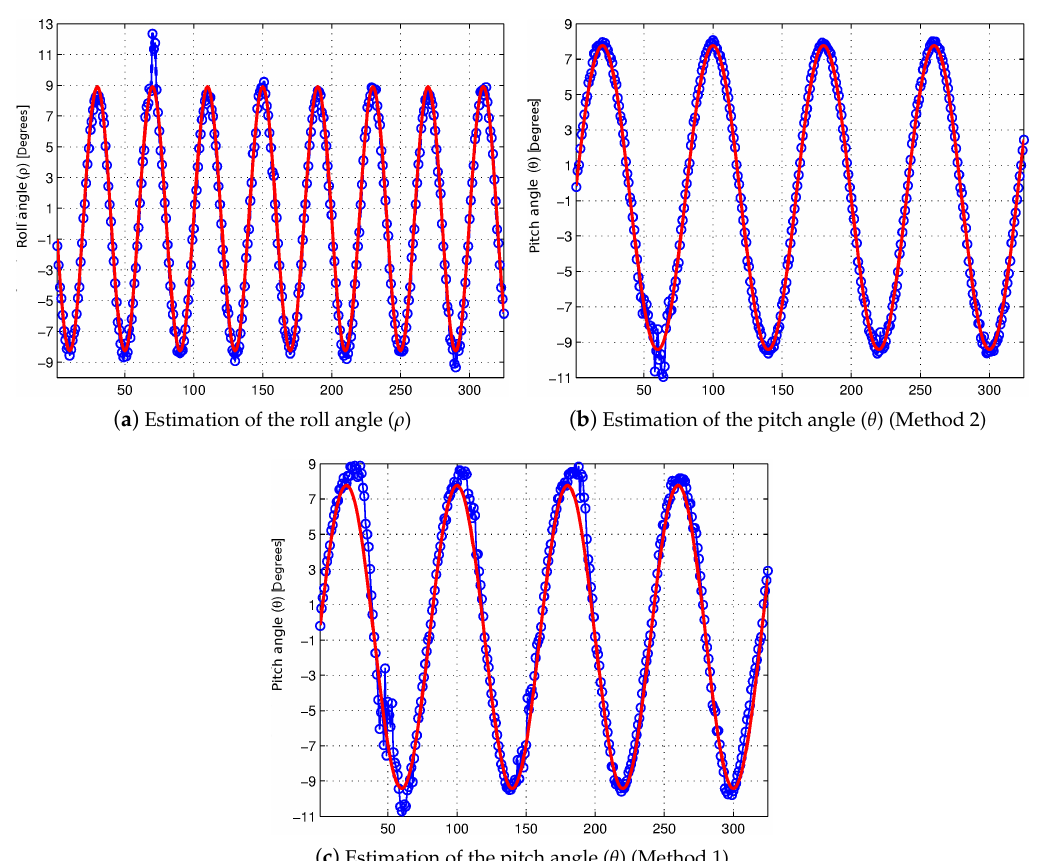
Figure 9. Self-calibration results of the roll angle ( ρ ) and the pitch angle ( θ ). The estimated values appear in blue and the ground truth in red. Results by using Method 2 ( a , b ). Results by using Method 1 ( c